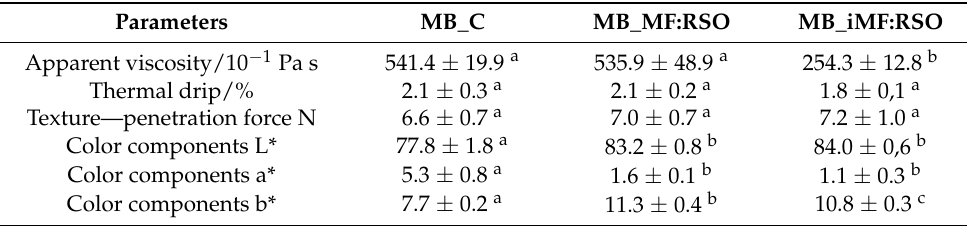
Table 3. Technological parameters of the model meat